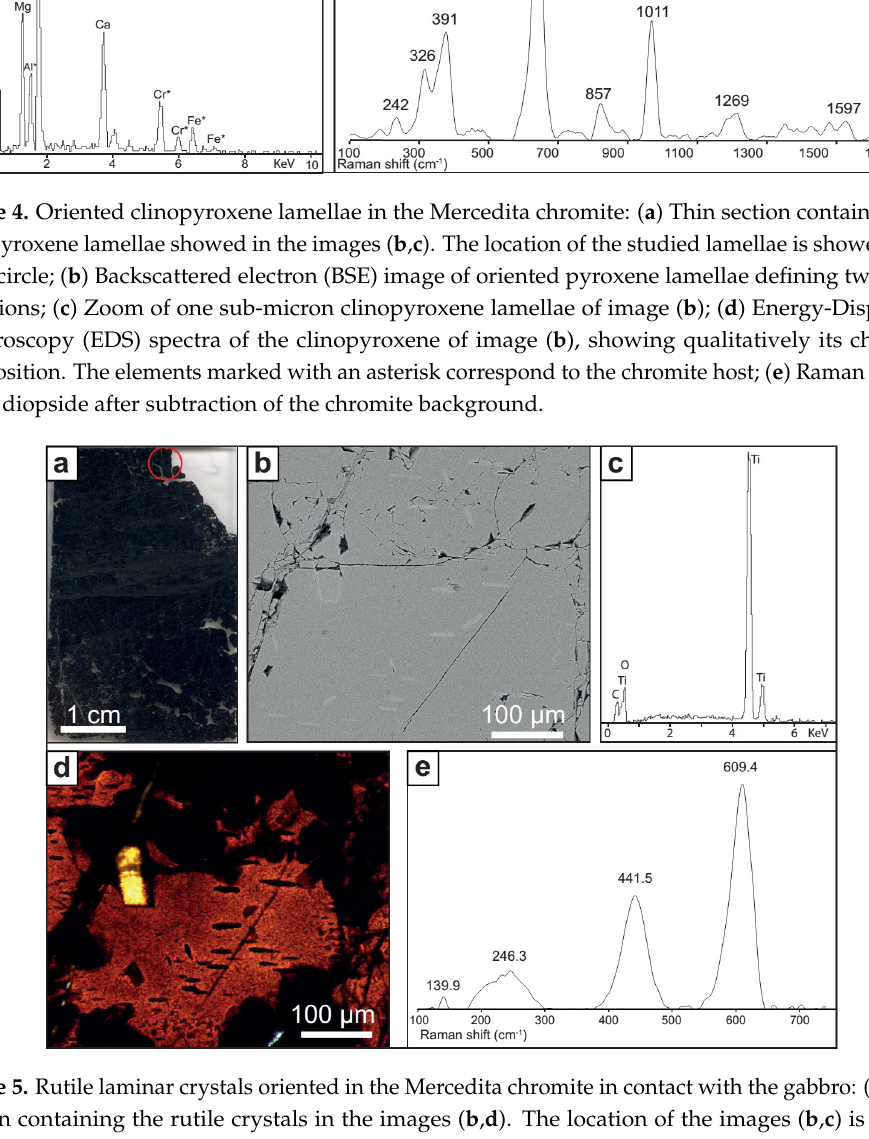
Figure 5. Rutile laminar crystals oriented in the Mercedita chromite in contact with the gabbro: ( a ) Thin section containing the rutile crystals in the images ( b , d ). The location of the images ( b , c ) is shown with a red circle; ( b ) Backscattered electron (BSE) image of oriented rutile crystals defining three main directions; ( c ) Energy-Dispersive Spectroscopy (EDS) spectra of the rutile of image ( b ), showing qualitatively its chemical composition; ( d ) Transmitted light optical microscope image of rutile crystals included in chromite; ( e ) Raman spectra of rutile after subtraction of the chromite